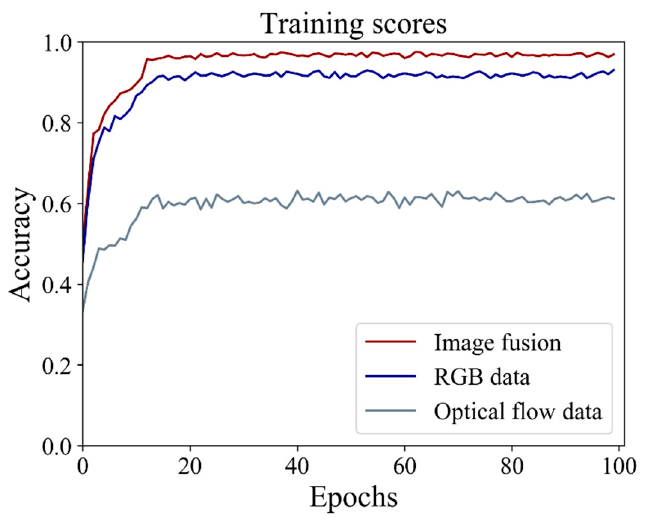
Figure 8. The result of feature fusion and the training result on the original RGB and optical flow data.